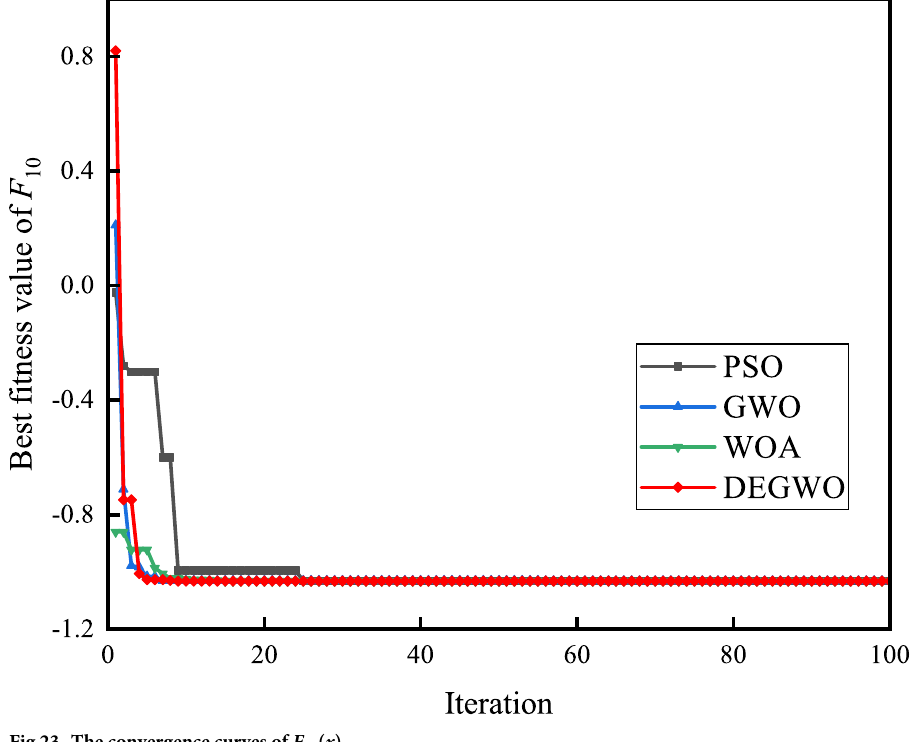
Fig 23. The convergence curves of F 10 ( x ).